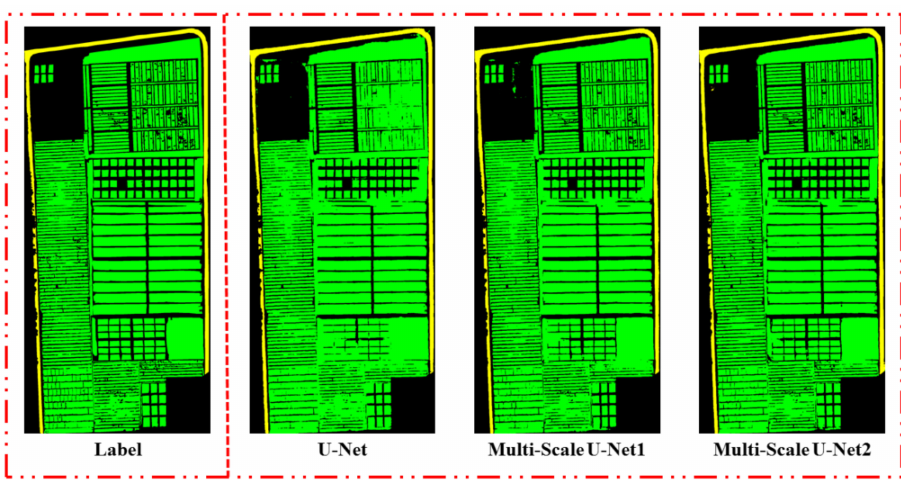
Figure 20. Three network models predict the results (GSD: 8.63 cm × 8.63